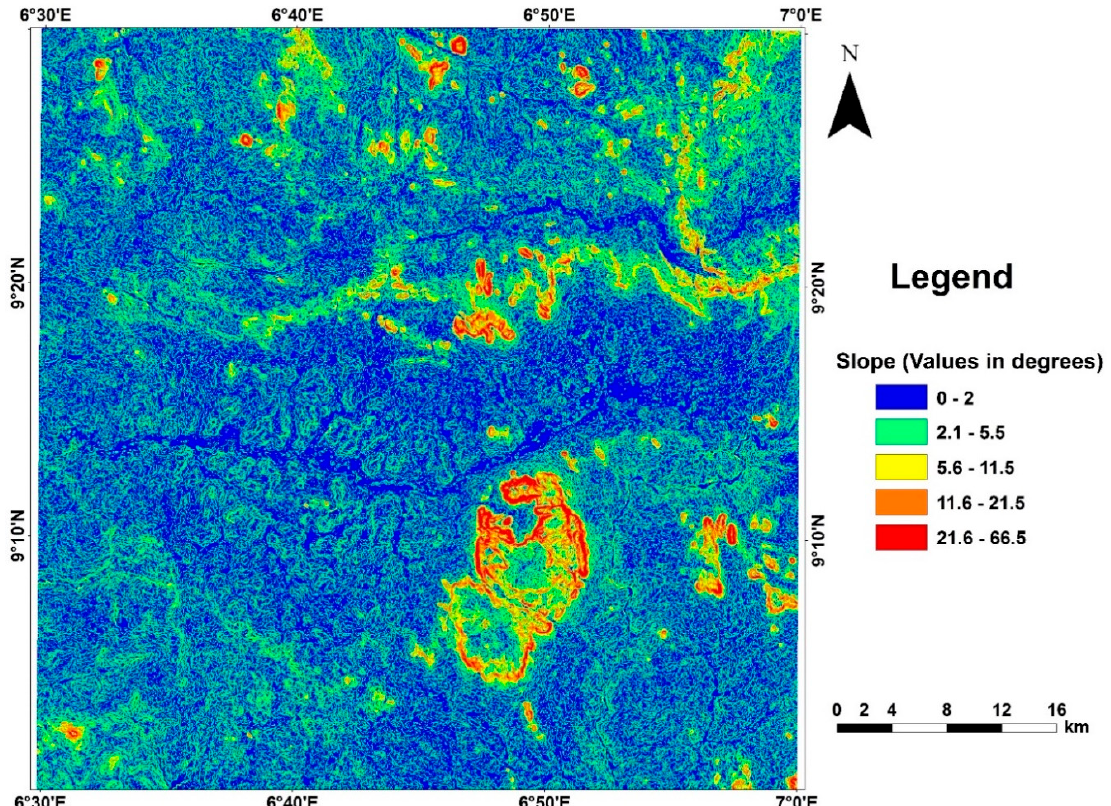
Figure 7. Slope map of Paiko Sheet 185 North Central Nigeria produced from SRTM DEM using the spatial analyst extension of ArcGIS. Low slope angles are representative of areas that encourage infiltration of rainfall, thus enhancing groundwater potential of the area.